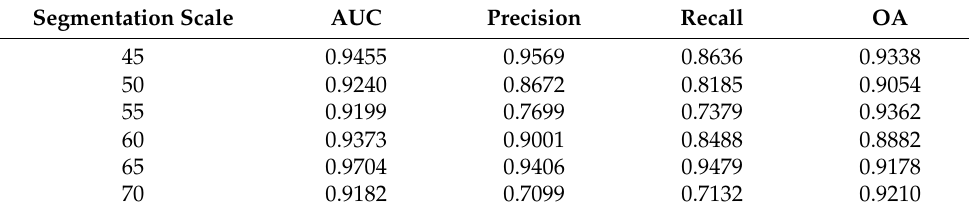
Table 3. Evaluating indicator values for the validation of the CART